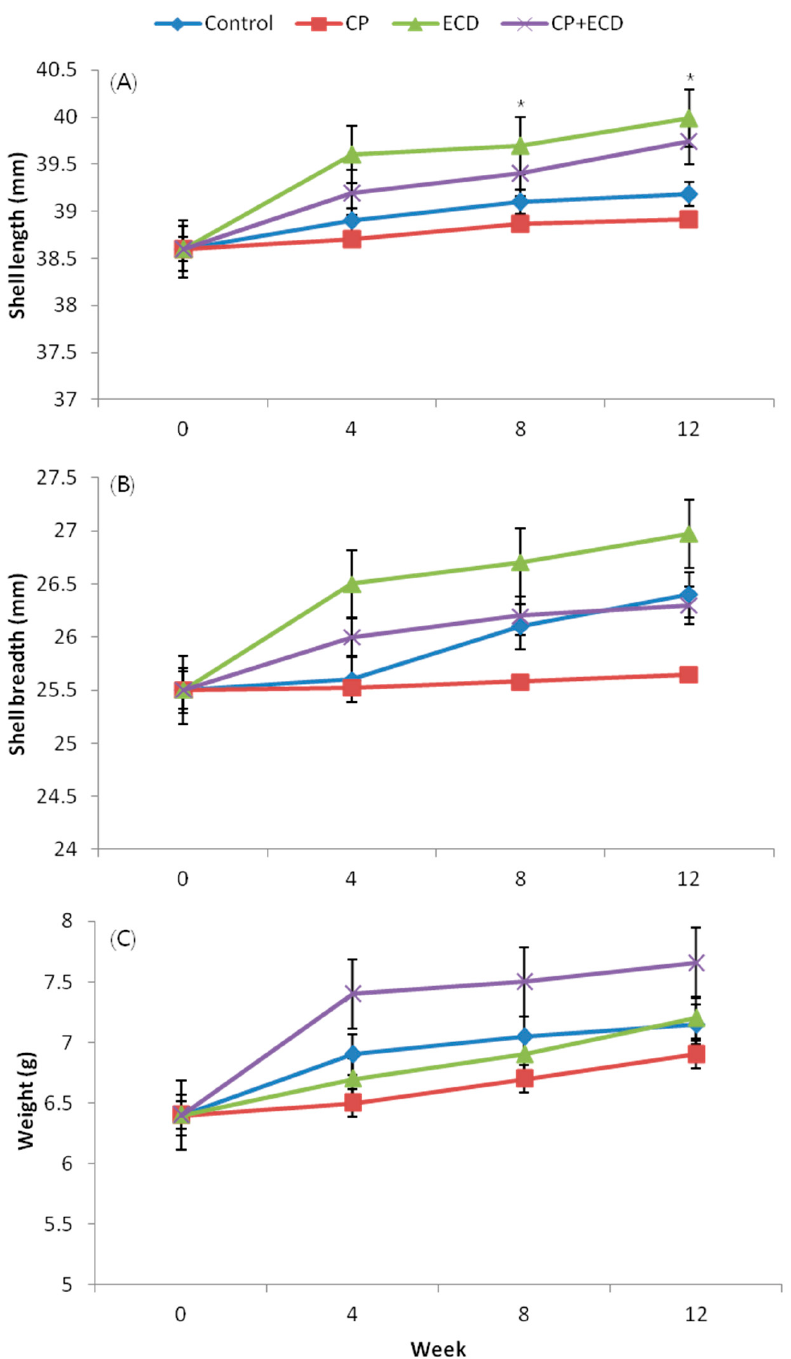
Figure 2. Variations in the growth of abalone ( H. discus ) after feeding the experimental diets supplemented with CP (6%), ECD (6%), and CP + ECD (3% + 3%) for three months (twelve weeks). ( A ) Shell length, ( B ) shell breadth, ( C ) total weight. Vertical bars in the figure show the SE of the means from three experimentations. * p < 0.05 for each control.